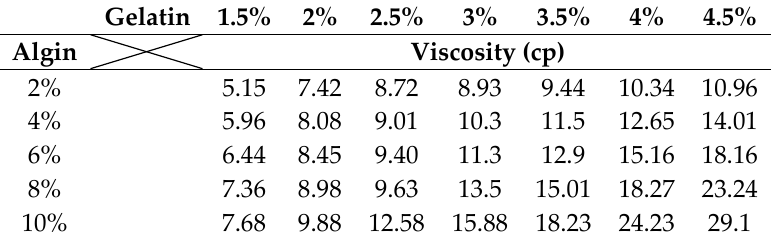
Table 1. Viscosity table of gelatin–sodium alginate mixed solution.